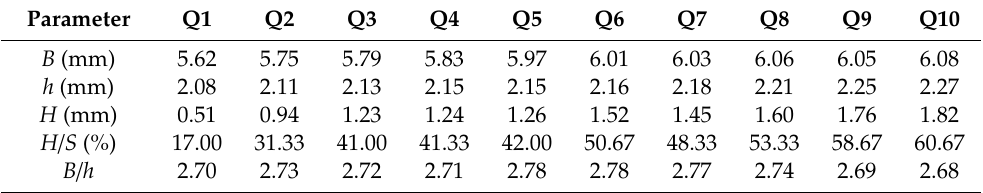
Table 5. Measurement of geometry characteristic parameters under forward inclination angles.